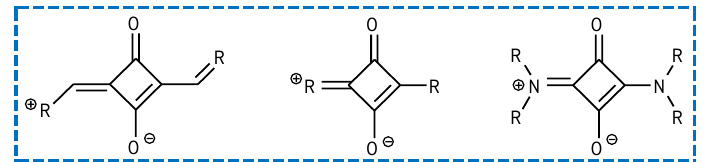
Figure 14. General structure of squaraine dyes.